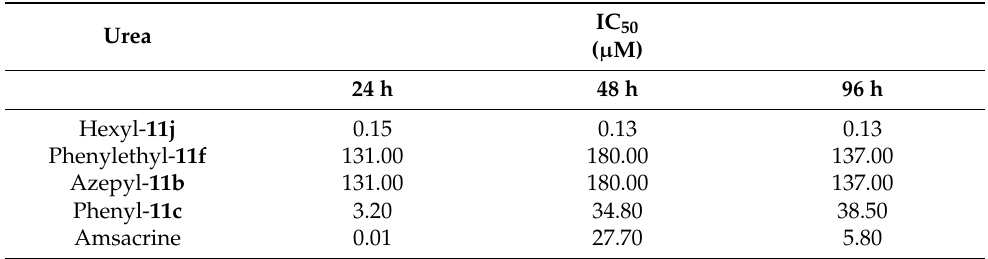
Table 5. Inhibition concentration (IC 50 ) of ureas 11b , 11c , 11f , 11j and amsacrine against immortalised foreskin fibroblasts (BJ-5ta) after 24, 48 and 96 h, determined by real-time cell analysis and dynamic monitoring of cell proliferation. IC 50 values are given as a micromolar